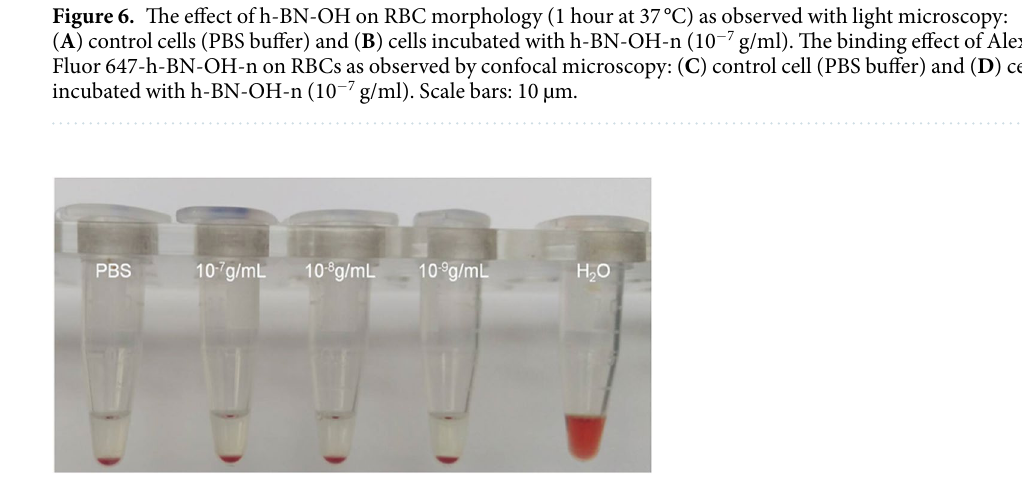
Figure 7. The erythrocyte sedimentation rate in the presence of h-BN-OH-n. The concentration of h-BN- OH-n is indicated on the EP vials. PBS – control